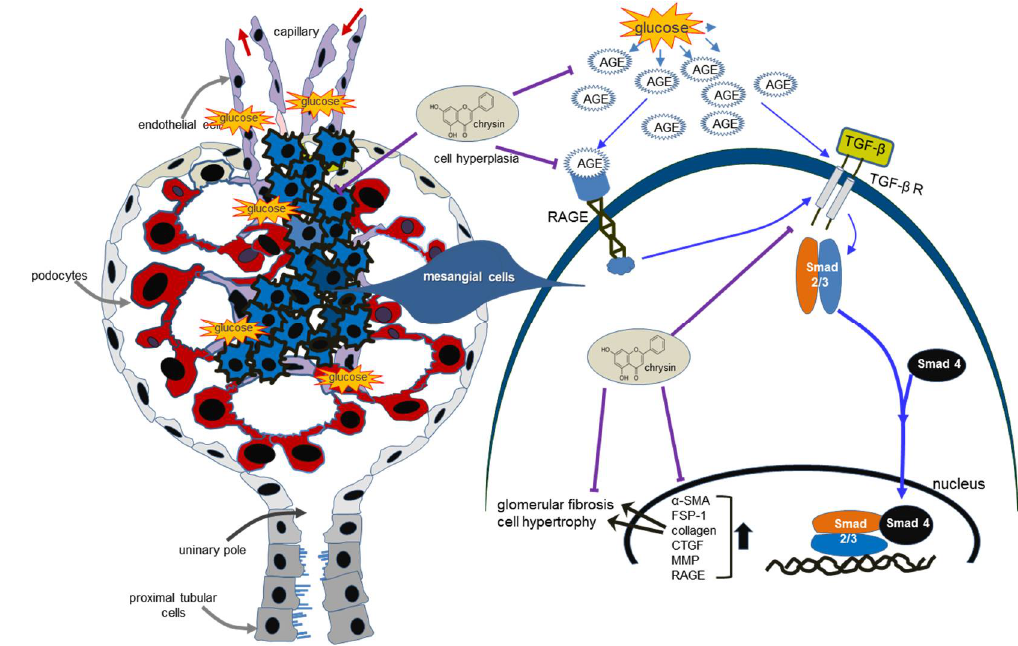
Figure 8. Schematic diagram showing the inhibitory effects of chrysin on kidney fibrosis in glucose/AGE-exposed renal mesangial cells and diabetic mice. Chrysin inhibited glomerulosclerosis and renal fibrosis through blocking AGEs-RAGE-TGF-β1 signaling in glucose-exposed kidneys. All the arrows indicate increase, activation or induction; ⊥ indicates inhibition or blockade.